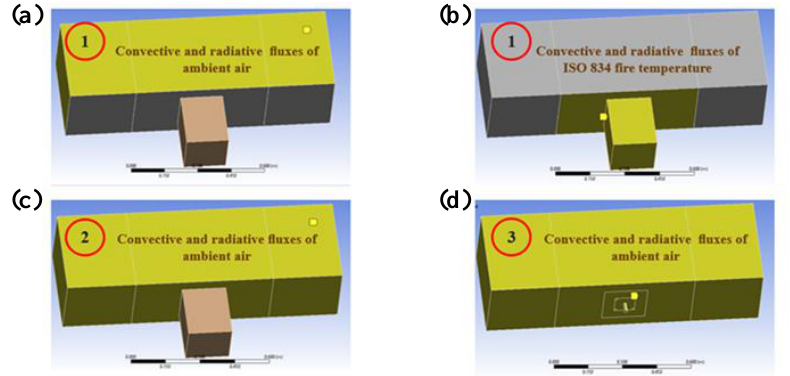
Figure 5. Boundary conditions applied in the three steps of the transient thermal analysis. To sum up, subfigures ( a , b ) in Figure 5 represent boundary conditions for step 1, subfigure ( c ) for step 2, and subfigure ( d ) for step 3.